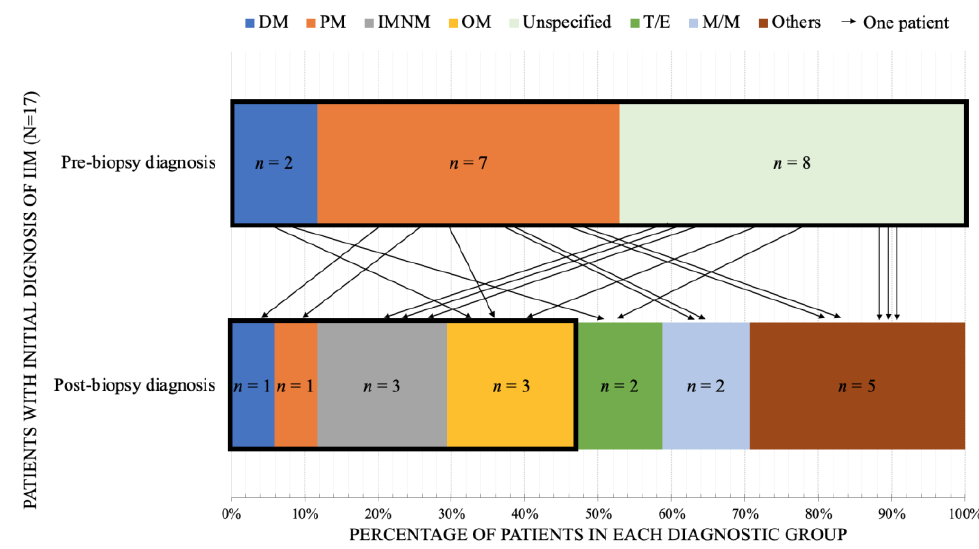
Figure 4. Change of subtypes or different types of diagnosis from pre-biopsy inflammatory myopathy. A total number of 17 patients with pre-biopsy diagnosis of IIM was demonstrated. The horizontal axis represented the percentage of patients in each diagnostic group. The thick border represented the collection of IIMs. Each arrow represented one patient and showed the corresponding change of diagnosis after muscle biopsy. The diagnosis of IIM was reduced by 53% after muscle biopsy was performed. More specific subgroups of IIMs were identified after muscle biopsy. IIM, idiopathic inflammatory myopathy; DM, dermatomyositis; PM, polymyositis; IMNM, immune-mediated necrotizing myopathy; OM, overlap myositis; M/M, metabolic/mitochondrial diseases; T/E, toxin/endocrine; n , number of patients. Table 4. Change of pre- and post-biopsy diagnosis in patients with idiopathic inflammatory myo- pathies.